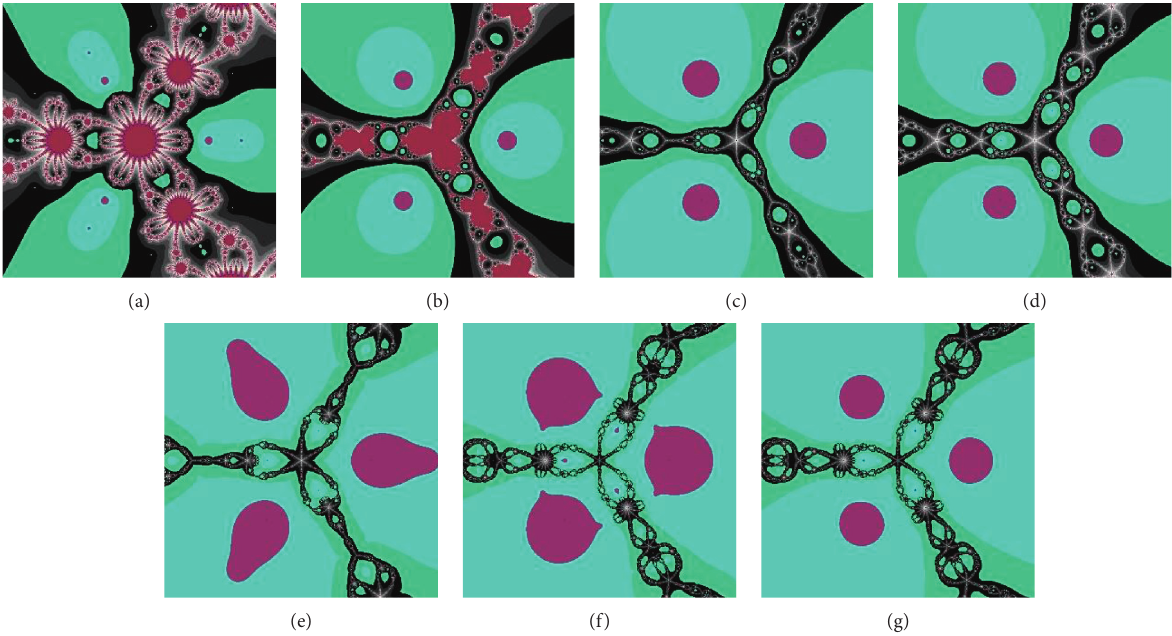
Figure 3: Polynomiographs for the polynomial p ( z ) using various iterative methods. (a) Polynomiograph for the polynomial p 3 ( z ) using NR2. (c) Polynomiograph for the polynomial p NR1. (b) Polynomiograph for the polynomial p 3 ( z ) using TM. (e) Polynomiograph for the polynomial p nomiograph for the polynomial p 3 ( z ) using Algorithm 1. (g) Polynomiograph for the polynomial p polynomial p 3